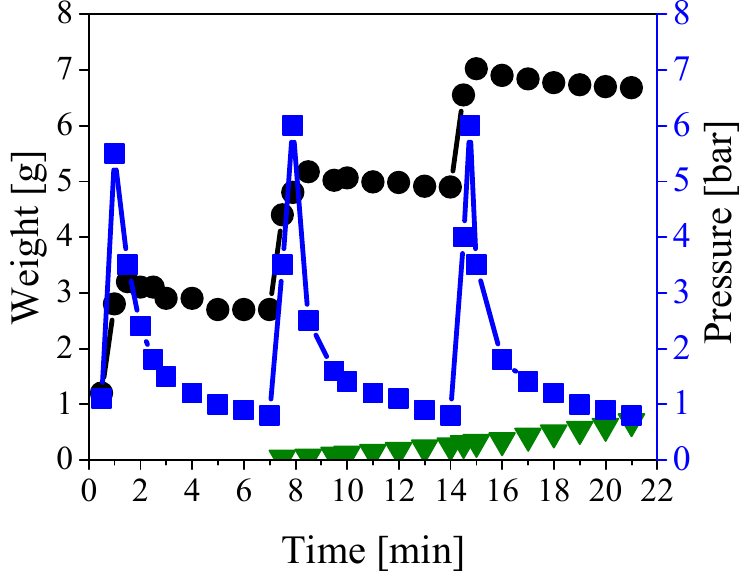
Figure 3. Weight of fed (black circles) and collected (green triangles) liquids, and pressure profile (blue squares) during the first three cycles of the pressurization/depressurization procedure.